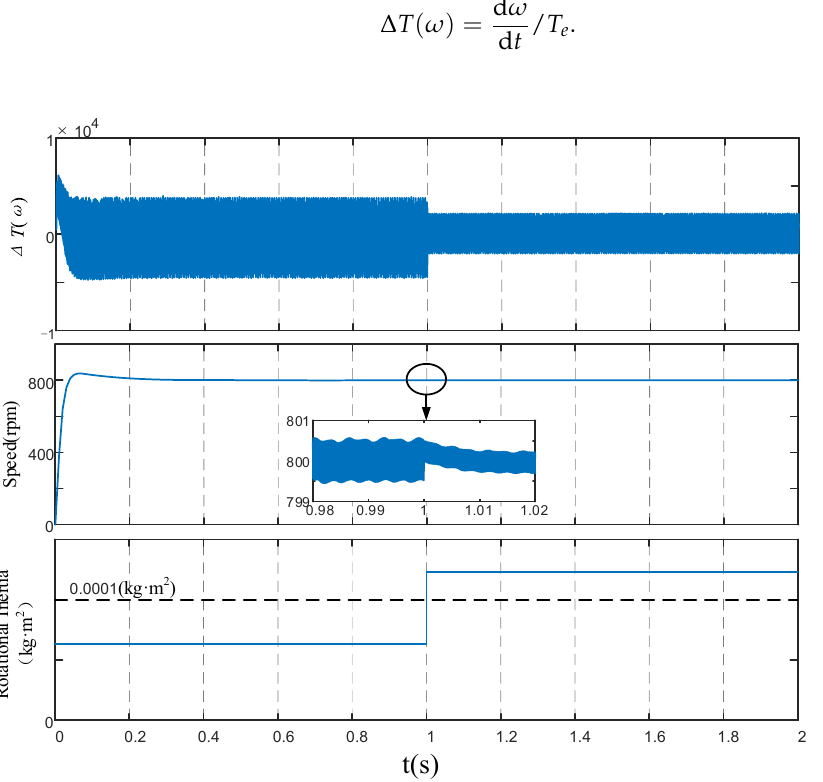
Figure 1. The tendency of torque and speed. The curve of Δ T ( ω ) changes with the change of the moment of inertia. Ignoring the motor startup phase, when the moment of inertia is doubled, the amplitude of the Δ T ( ω ) curve is reduced by about 55%. Therefore, the vibration amplitude of Δ T ( ω ) is used as the basis for judging whether the moment of inertia has changed. The adaptive module will only start and then modify the control parameters when the vibration amplitude of Δ T ( ω ) changes. When establishing the moment of inertia identification model of PMSM below, ω and 𝑇 (cid:3032) are used as the input parameters of the identification module.